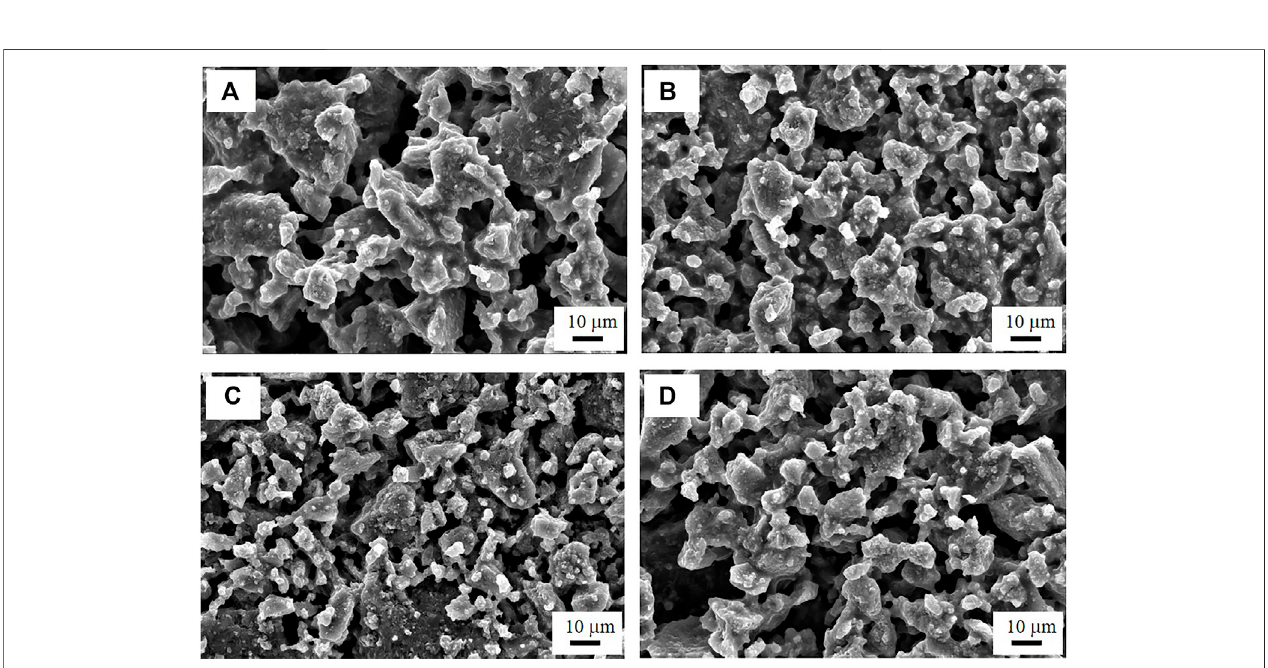
FIGURE3| FE-SEMimagesofthe (A) dry-milledLi 6 PS 5 Clpowdersample,andwet-milledLi 6 PS 5 Clpowdersamplespreparedusing (B) heptane, (C) toluene,and (D) xylene.